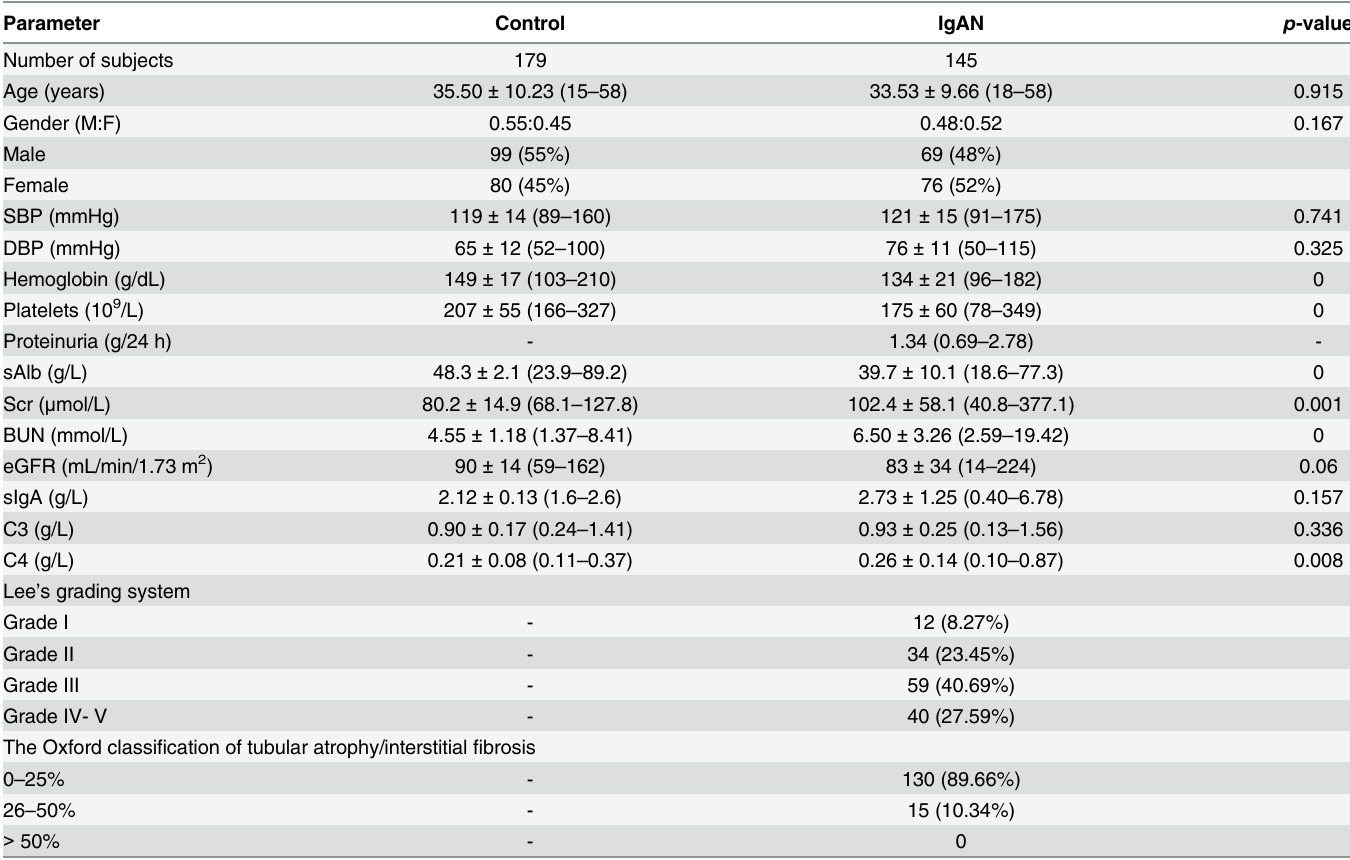
Table 1. Demographic, clinical, and histological data in controls and IgAN patients.